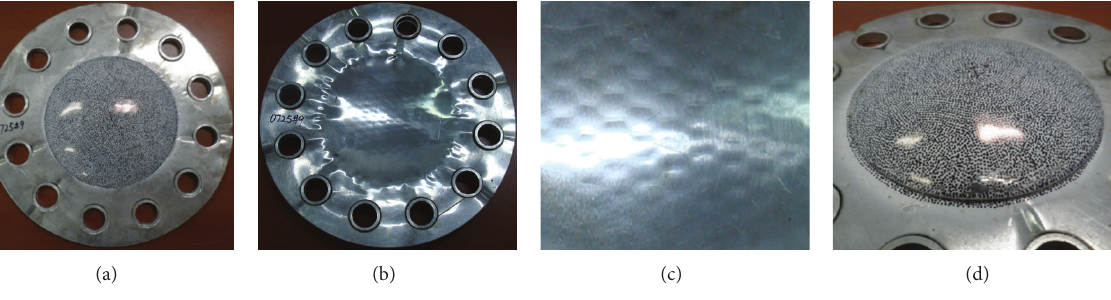
Figure 14: Sandwich panel after impulsive loading, 𝑐 = 7.5 mm, view; (d) detail of the wet face sheets near